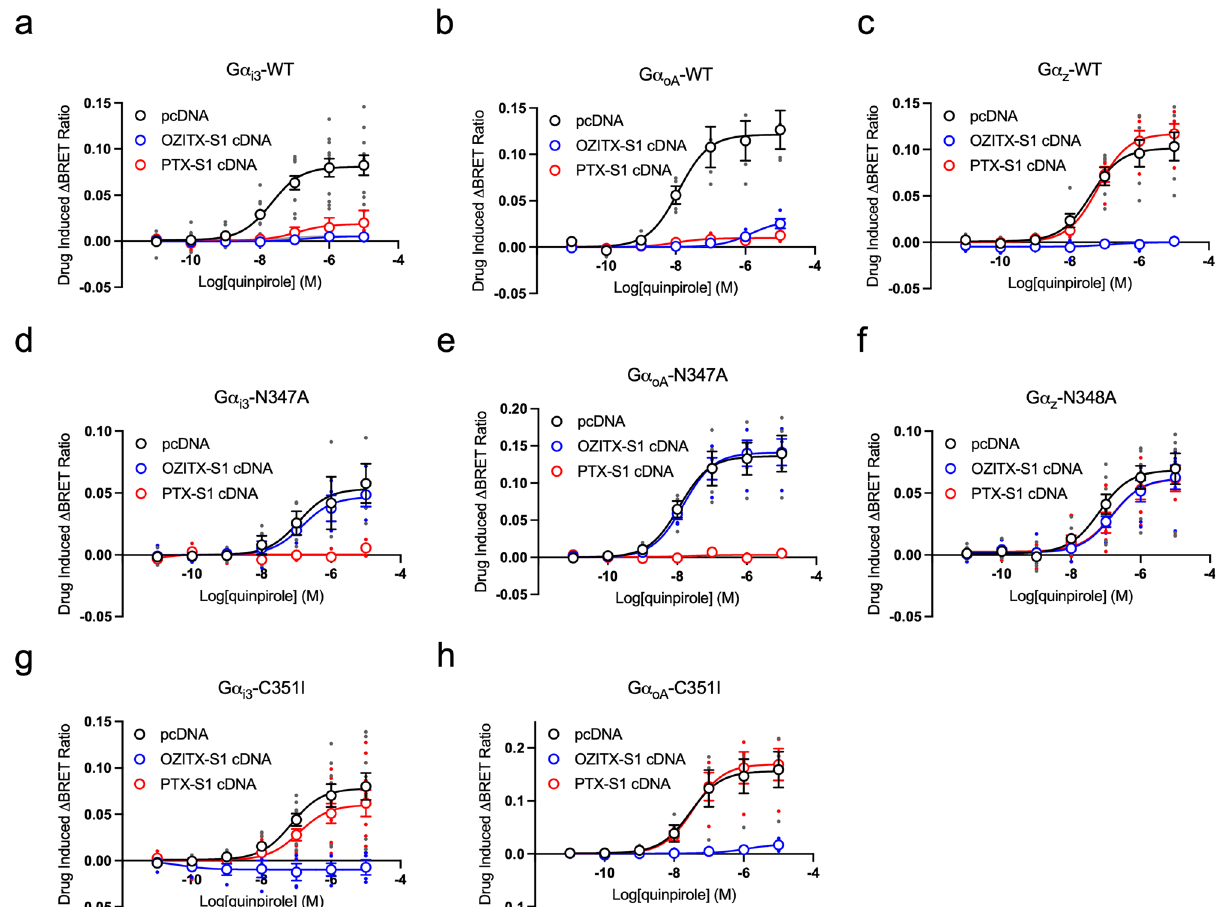
Fig. 5 OZITX sensitivity of G α i subfamily carboxy-tail Asn347/348 mutants. a G α i3 -WT activation, n = 11. b G α oA -WT activation, n = 4. c G α z -WT activation, n = 5. d G α i3 -N347A activation, n = 4. e G α oA -N347A activation, n = 4. f G α z -N347A activation, n = 6. g G α i3 -C351 activation, n = 4. h G α oA - C351 activation, n = 4. The G-protein activation assay was performed on WT, Asn347Ala/Asn348Ala (putative OZITX site) and Cys351Ile (PTX- insensitive) mutants. Cells were transfected with the D 2 R, the particular G α mutant, the G-protein activation sensors and either a pcDNA3.1 + control (black open circles), OZITX-S1 cDNA (blue open circles) or PTX-S1 cDNA (red open circles). Cells were then stimulated with increasing concentrations of quinpirole before BRET detection. Data represent the mean drug-induced increase in BRET ratio from vehicle ± SEM. Individual replicates are shown as small